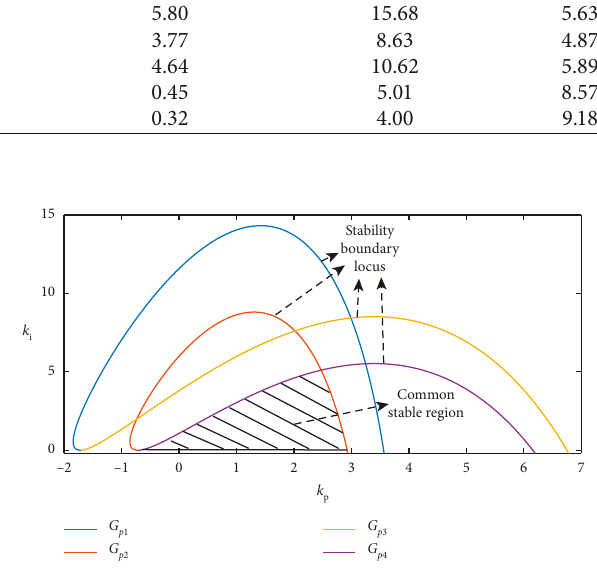
Table 4: Performance metrics comparison of various methods in example B (other data cited from [34]). Controller